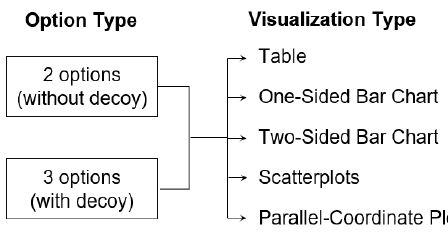
Figure 4. Between subject design with two factors, option type and visualization